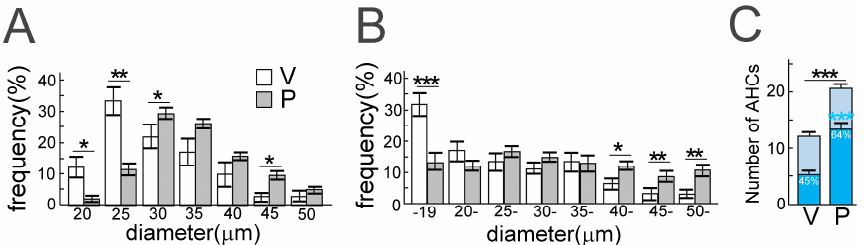
Figure 7. Perampanel administration for 90 days rescued anterior horn cells (AHCs) from death in conditional adenosine deaminase acting on RNA 2 (ADAR2) knockout mice (AR2). ( A , B ) Frequency histogram of AHC diameters in the perampanel group (P, gray columns) and the vehicle group (V, white columns): by TO-PRO-3 staining ( A ) and by choline acetyltransferase (ChAT) immunostaining ( B ). The vertical axis indicates the proportion of the total number of AHCs with diameters in each range; ( C ) The number of ChAT-positive AHCs with a diameter of more than 20 µm in AR2 mice treated with (P) or without (V) perampanel. V, vehicle (methyl cellulose)-treated AR2 mice ( n = 5); P, perampanel-treated AR2 mice ( n = 5). Means (columns) and standard errors of the mean (SEMs) (bars) are indicated. n = 5; * p < 0.05, ** p < 0.01, *** p < 0.001, Mann–Whitney U test against the value of the vehicle group.